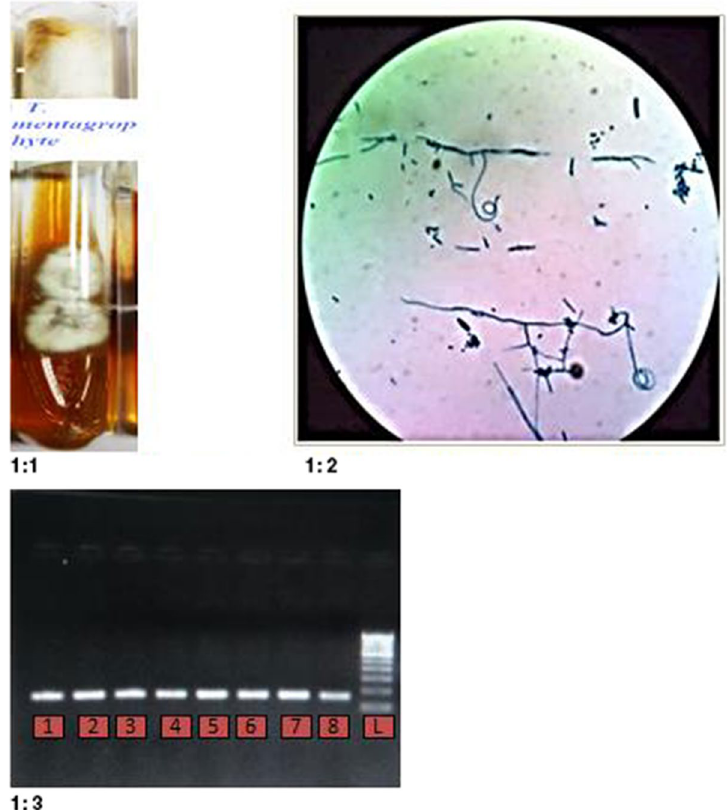
Figure 1. 1.1 Culture picture of T. mentagrophytes . 1.2 Microscopic picture of T. mentagrophytes in LPCB. 1.3 T. mentagrophytes picture at 130 base pair Lane 1–8 & L:1–7- samples, 8-ATCC of T. mentagrophytes & L-ladder 100 base